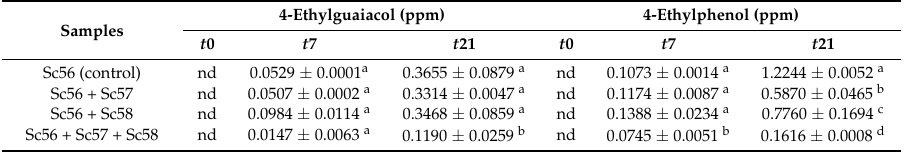
Table 2. Volatile phenol content (ppm) of grape musts spiked with B. bruxellensis Unifg 8 and inoculated with different combinations of three S. cerevisiae strains during alcoholic fermentation (AF): t 0, day of inoculation; t 7, 7 days from the inoculation; t 21, 21 days from the inoculation (nd, volatile phenol not detected). Results of the ANOVA analysis are shown as letters on the data corresponding to the concentration of volatile phenols: different letters on the same column indicate significant differences of